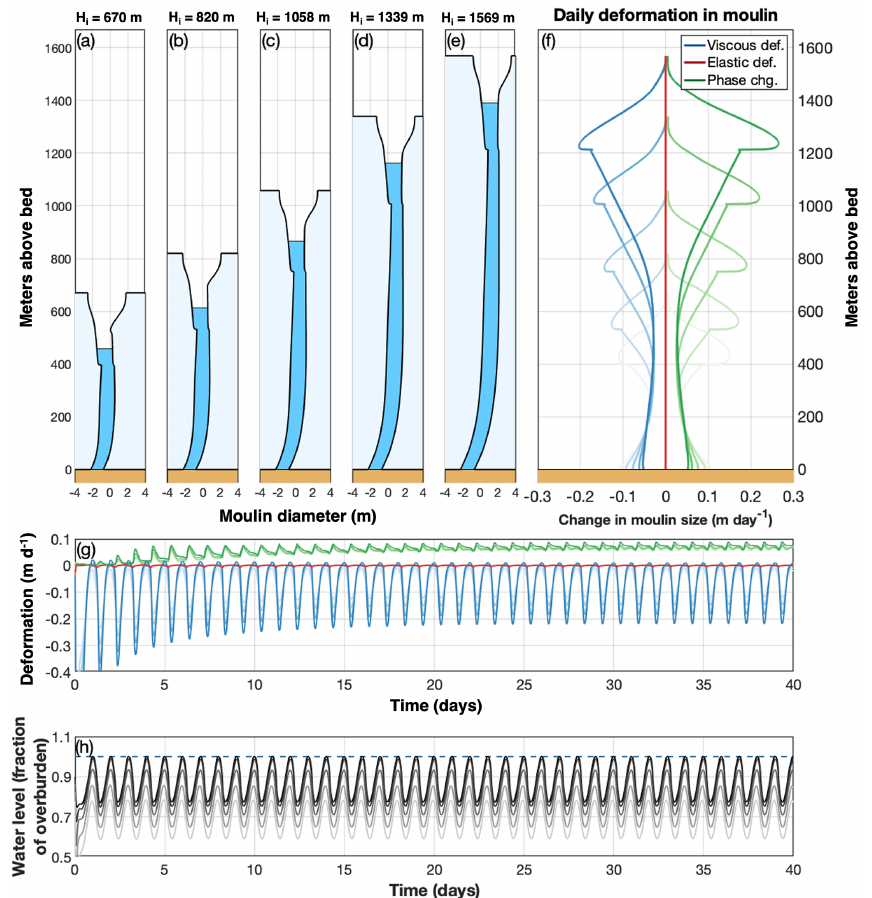
Figure 5. Contributions of viscous deformation, elastic deformation, and phase changes to moulin geometry. (a–e) Equilibrium geometries of five moulins in ice of different ice thicknesses H and different distances from the terminus (same as Fig. 6o and p) averaged over the final 24h period of a 40d model run. (f) Vertical variation in viscous deformation (blue), elastic deformation (red), and phase change (green) contributions to moulin geometry averaged over the same 24h period. Negative values indicate contributions to moulin closure; positive values open the moulin. Darkening shades of each color map to moulins of increasing ice thickness. Closure and opening rates are greatest at the minimum daily water level (which is inferable by the lower notch in the moulin wall). (g) Time series of the components shown in panel (f) (colors the same) at the mean water level over the entire 40d model run. The greater diurnal range in water level in moulins in thick ice drives the observed larger diurnal variations in viscous deformation. (h) For reference, moulin water level as a fraction of overburden for different ice thicknesses. Lighter greys indicate thinner ice; the blue dashed line indicates where fraction of overburden =